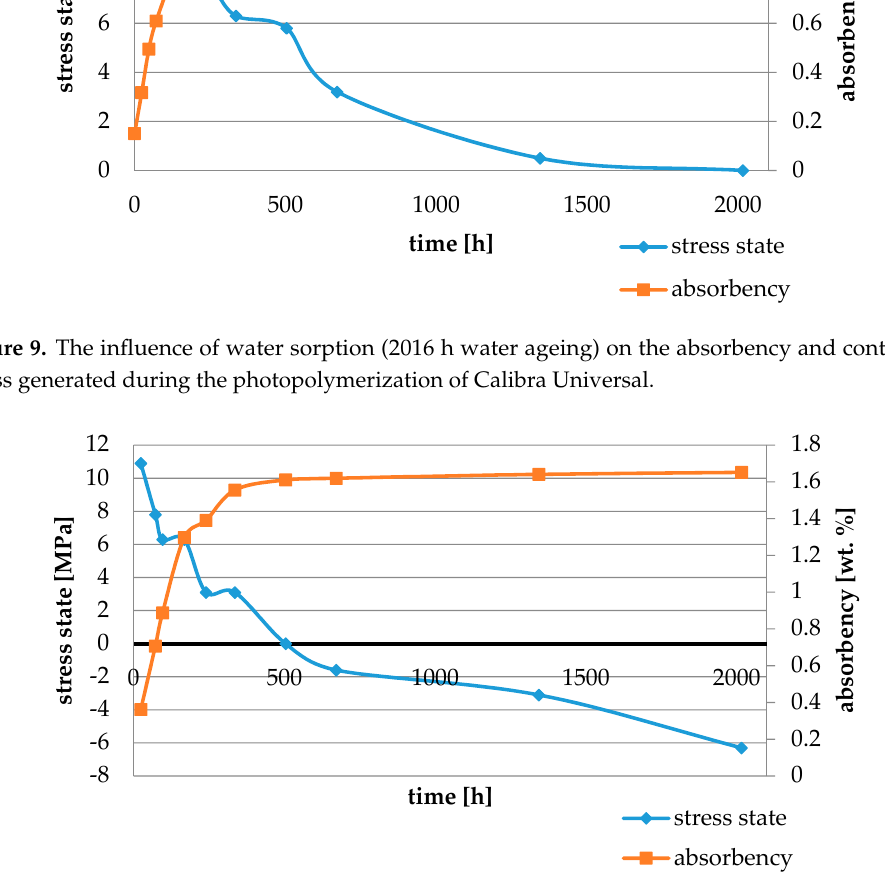
Figure 10. The influence of water sorption (2016 h water ageing) on the absorbency and contraction stress generated during the photopolymerization of Maxcem Elite Chroma.